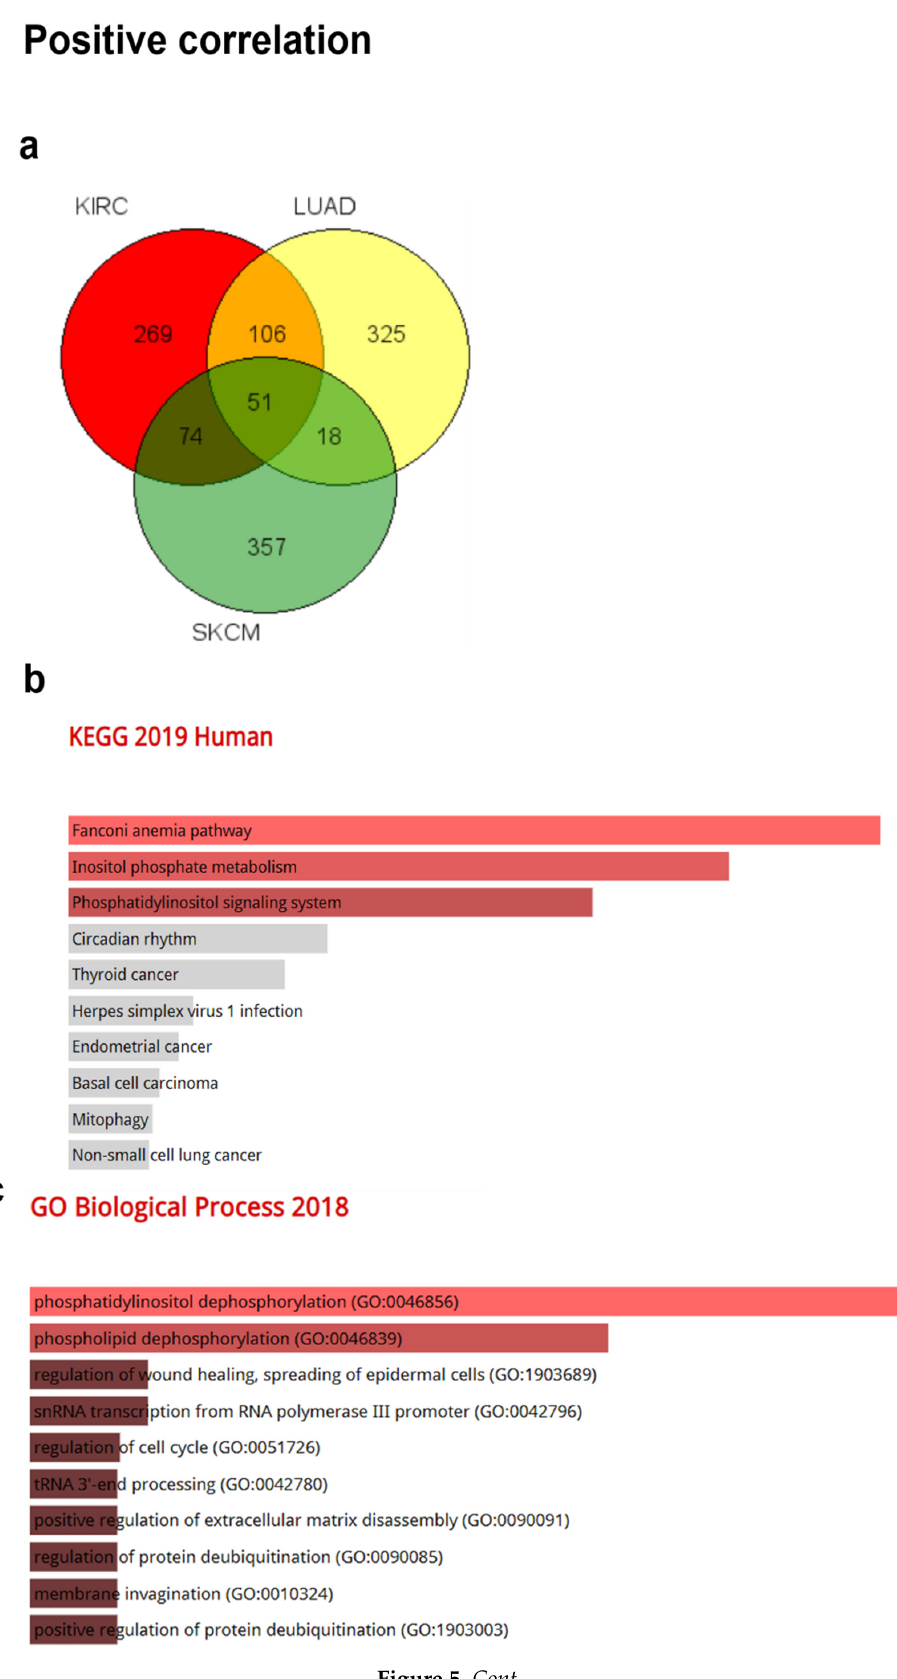
ositol dephosphorylation” in the “biological process” classification (Figure 5c), “phospha- tidylinositol monophosphate phosphatase activity” in “molecular function” (Figure 5d), and “kinetochore microtubule” in “cellular component” (Figure